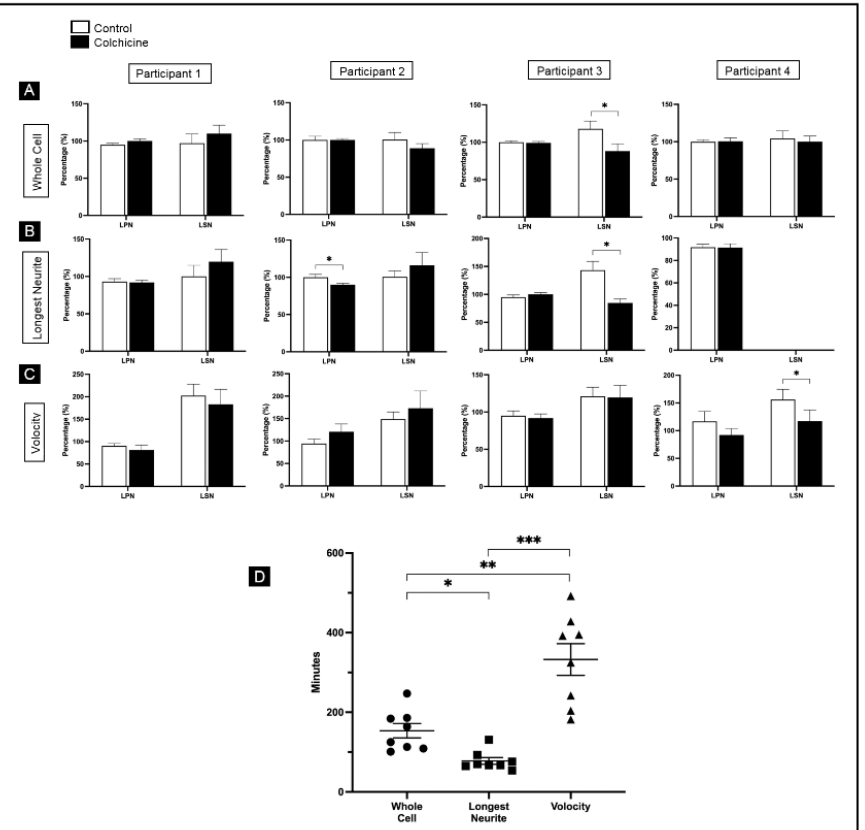
Figure 3. Comparison between three different tracing methods. ( A ) Bar graphs comparing MDNCs’ structural response to colchicine versus MDNCs under control conditions after tracing each MDNC in its entire. Structural parameters include longest primary neurite (LPN) and longest secondary neurite (LSN). Data are presented as mean ± SEM. Differences were assessed using the non-parametric Mann–Whitney test. Participant 1 (P1): for LPN n = 37 for control and n = 32 for colchicine; for LSN, n = 23 for control and n = 20 for colchicine. P2: for LPN n = 38 for control and n = 35 for colchicine; for LSN, n = 15 for control and n = 19 for colchicine. P3: for LPN n = 47 for control and n = 34 for colchicine; for LSN, n = 41 for control and n = 29 for colchicine. P4: for LPN n = 51 for control